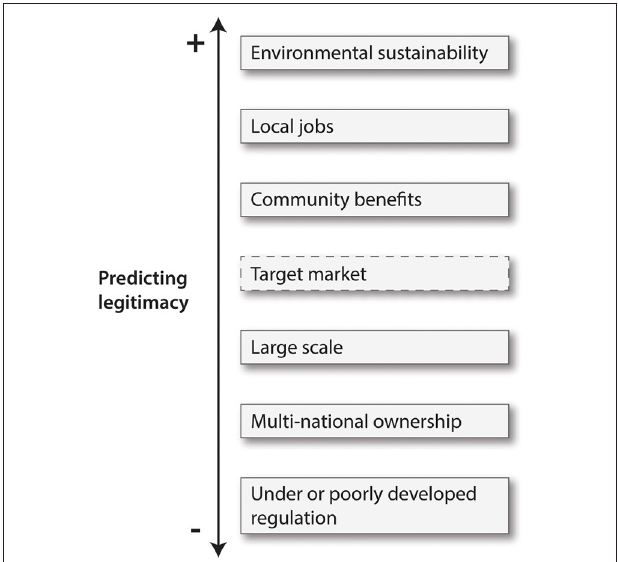
FIGURE 6 | Characteristics predicting a legitimate seaweed cultivation sector in Scotland, based on the results of all three factors. Boxes in black are likely to be less legitimate, boxes in gray are likely to be more legitimate, and the dashed line box shows the characteristics that is